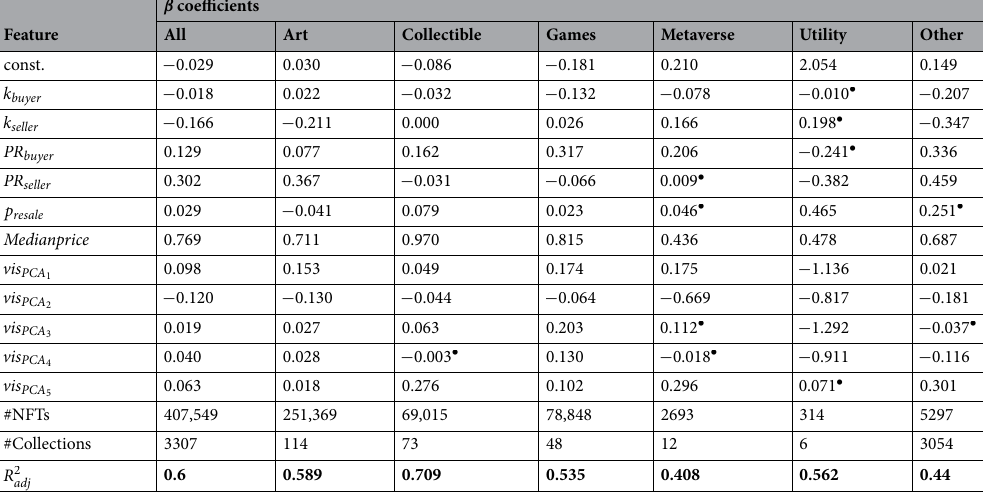
Table 1. Secondary sale price prediction. Linear regressions to predict the NFTs’ median secondary sale price one month after their primary sale from three families of features: centrality on the trader network ( k , PR ), history of sales in the NFT’s collection (namely prior probability of secondary sale p resale and median sale price 1 week before the sale medianprice ), and visual features ( vis PCA different categories of NFTs independently. For each category, the number of NFTs and collections it contains is reported. The R 2 adj is a measure of goodness of fit, and it quantifies the proportion of the data variance explained by the model. The p-values of all β coefficients are < 0.01 except for those marked with all > 0.05